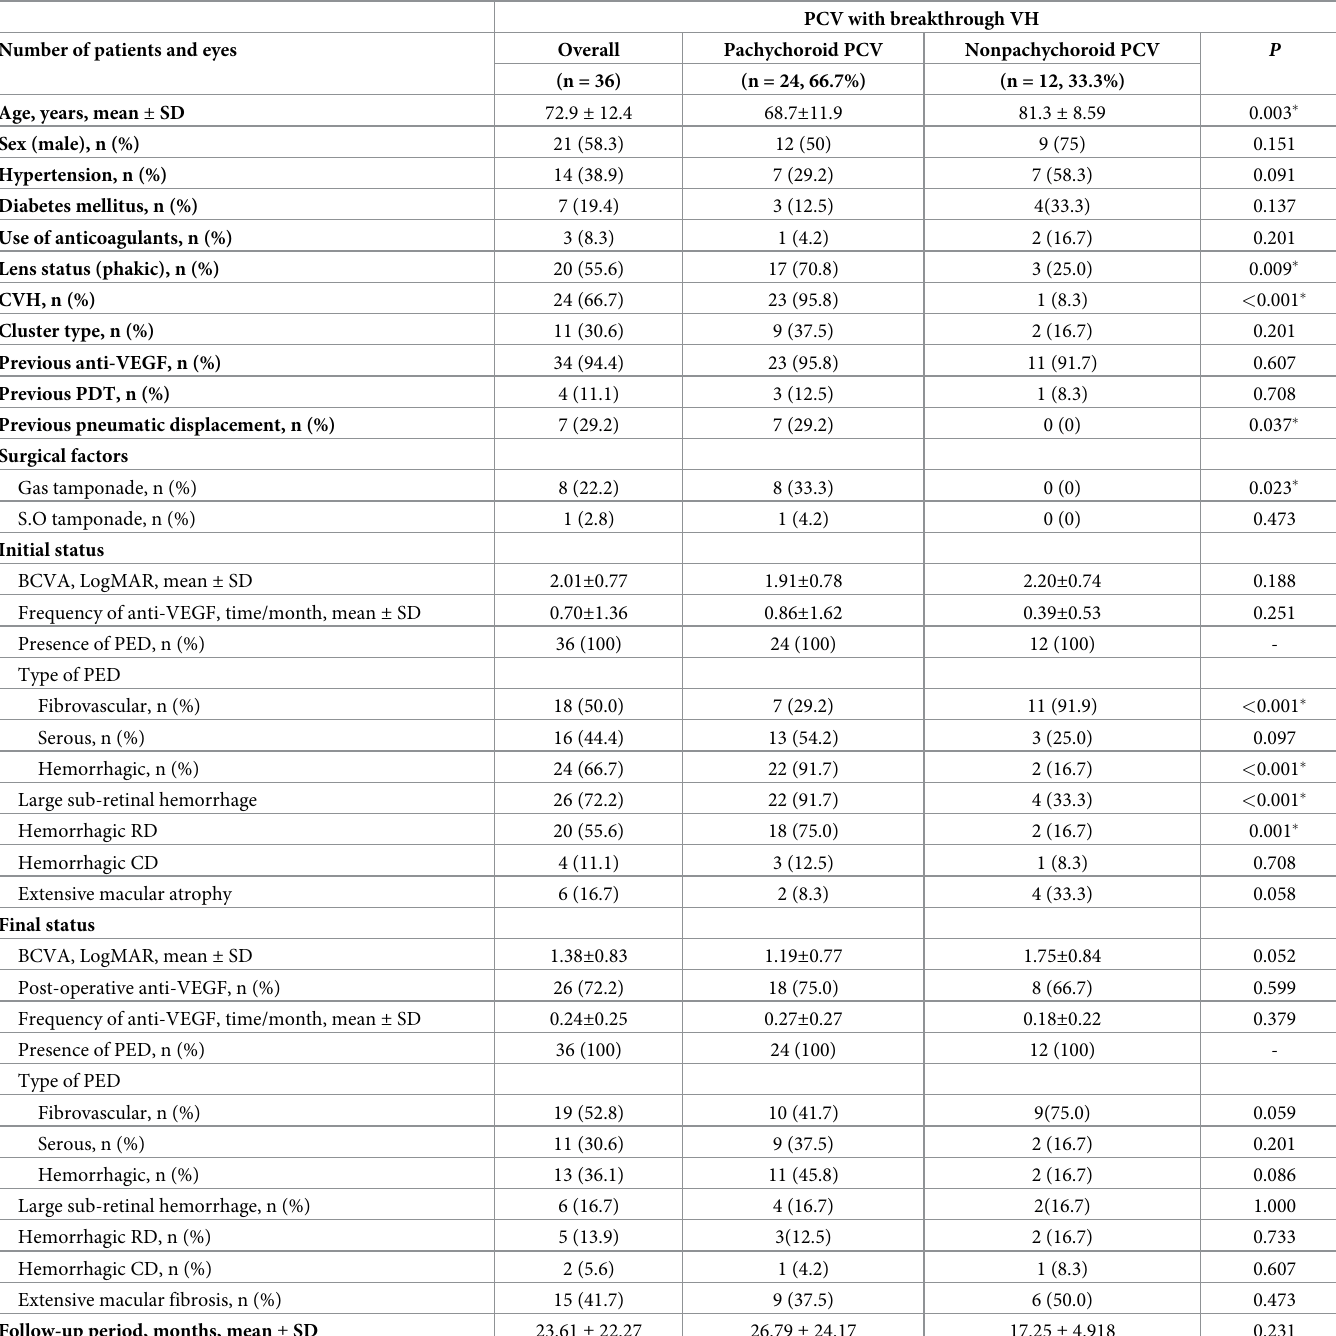
Table 3. Difference in pachychoroid status of polypoidal choroidal vasculopathy with breakthrough vitreous